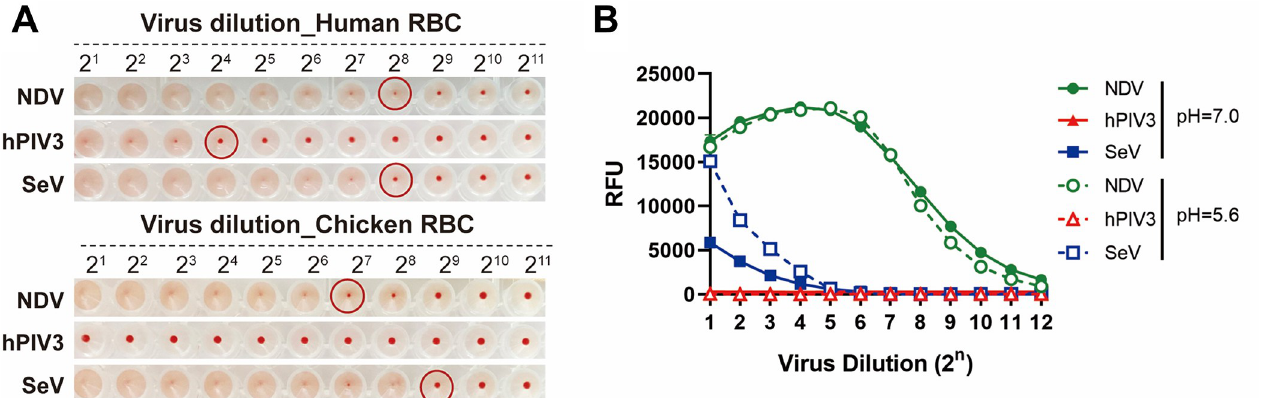
Fig 1. Characterization of virus-receptor interactions using classical techniques. ( A) Hemagglutination assay. Serial two-fold dilutions of NDV, hPIV3 and SeV (starting concentration 2x10 10 virus particles/ml as determined by nanoparticle tracking analysis [NTA]) were incubated with human or chicken erythrocytes at 4˚C for 2h. A red erythrocyte pellet indicates the absence of hemagglutination. Red circles indicate the first dilution at which no hemagglutination was observed. ( B) Sialidase activity assay. Sialidase activity of serial two-fold dilutions of NDV, hPIV3 and SeV (starting concentration 2x10 10 virus particles/ml) was assessed in triplicate at 37˚C using the fluorogenic substrate MUNANA at pH 5.6 or 7.0. Means and standard deviations are graphed. The fluorescence generated from MUNANA cleavage was measured using a plate reader (in relative fluorescence units [RFU]).